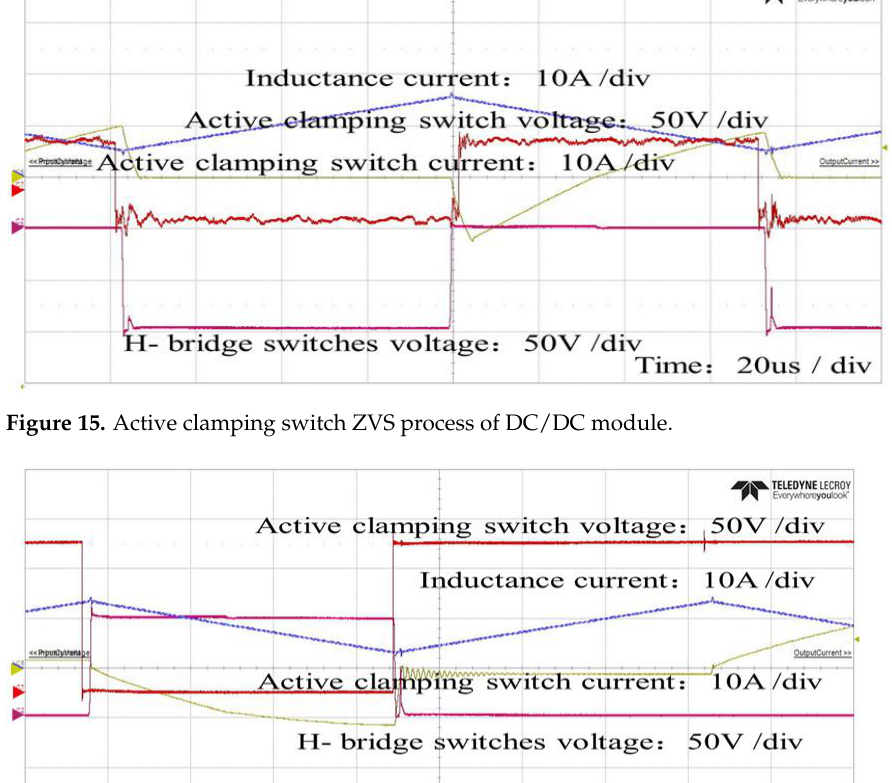
Figure 16. H-bridge switches ZVS process of DC/DC module.